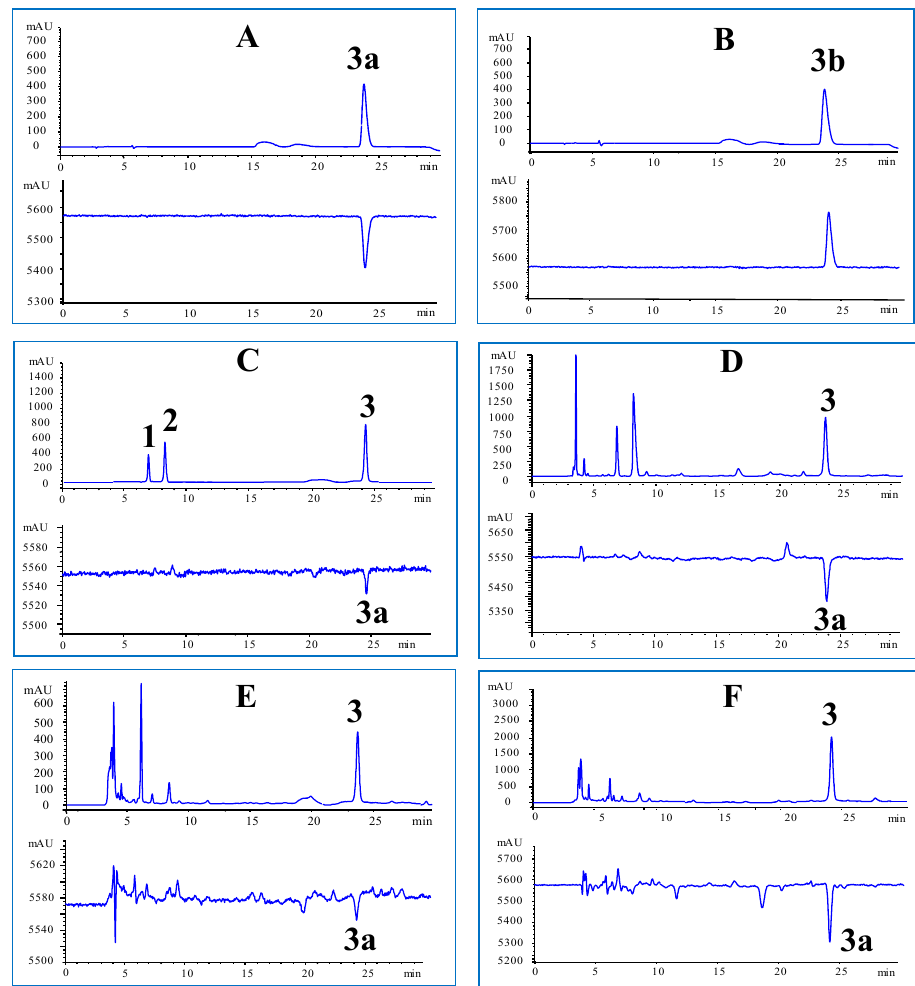
Figure 1. Representative UV ( upper ) and CD ( lower ) chromatograms of glucosinolates, crude drug, decoction pieces and granules of Radix Isatidis . ( A ) R -goitron, ( B ) S -goitrin, ( C ) mixed glucosinolate references, ( D ) crude drugs of R. Isatidis (B10), ( E ) decoction pieces of R. Isatidis (B22), ( F ) granules of R. Isatidis (B35). 1 : progoitrin, 2 : epiprogoitrin, 3 : R,S -goitrin, 3a : R -goitrin, 3b : S